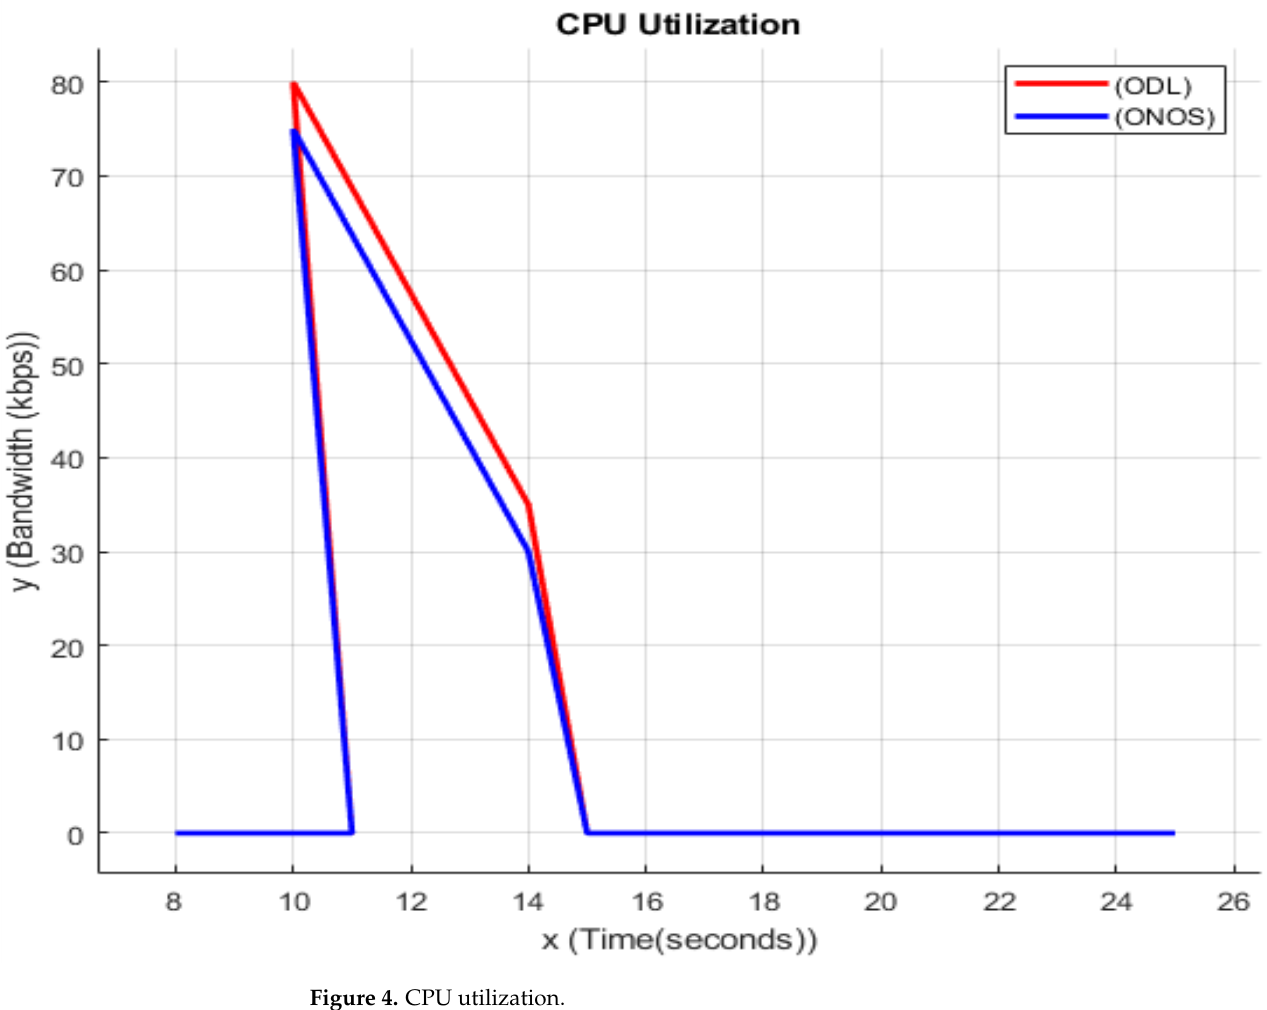
Figure 4. CPU utilization.